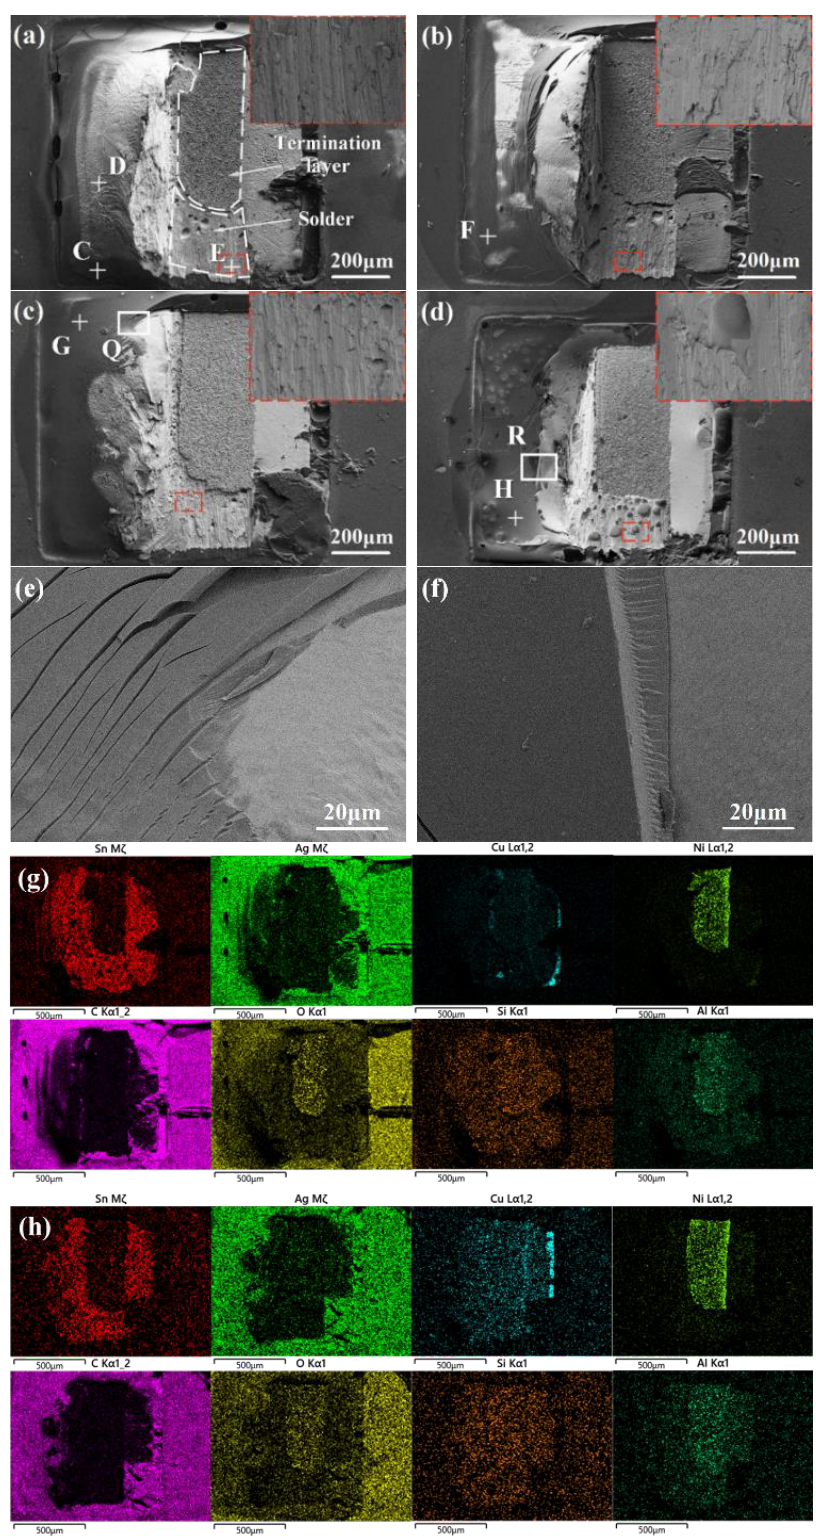
Figure 10. Fracture surfaces of plain SAC305 and SAC305-ER solder joints: ( a ) plain SAC305, ( b ) x = 4 wt %, ( c ) x = 8 wt %, ( d ) x = 12 wt %, ( e ) enlarged image of region Q, ( f ) enlarged image of region R, ( g ) the elemental mapping of ( a ), ( h ) the elemental mapping of ( c ).